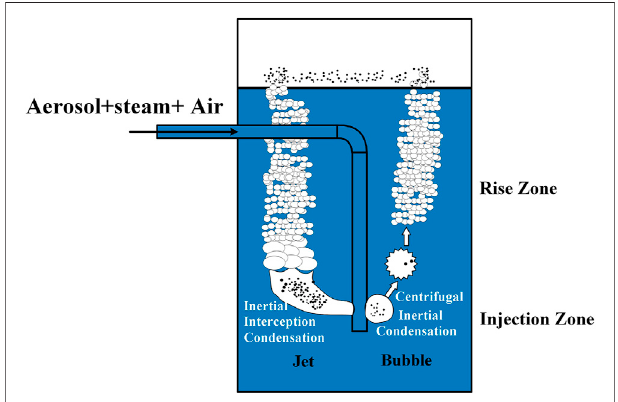
FIGURE 4 | Schematic diagram of the pool scrubbing process.